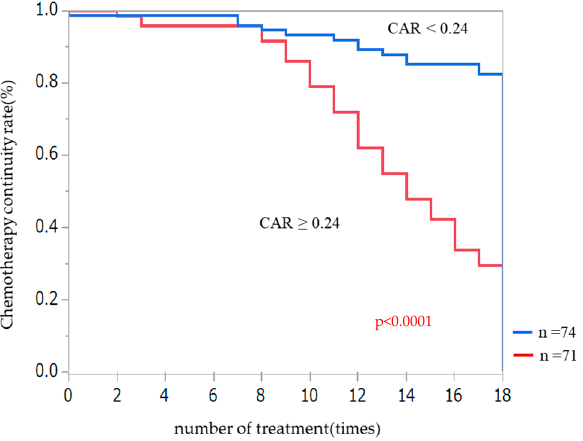
Figure 3. Kaplan–Meier curves of chemotherapy continuation according to the CAR. Patients were divided into two groups with 0.24 as the cut-off value. CAR: C-reactive protein-to-albumin ratio. Table 4. Hazard ratio of chemotherapy interruption according to CAR.